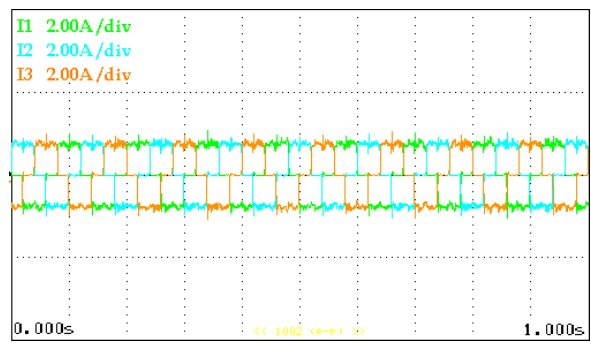
Figure 12. Currents in the BLDC motor with no phase fault.